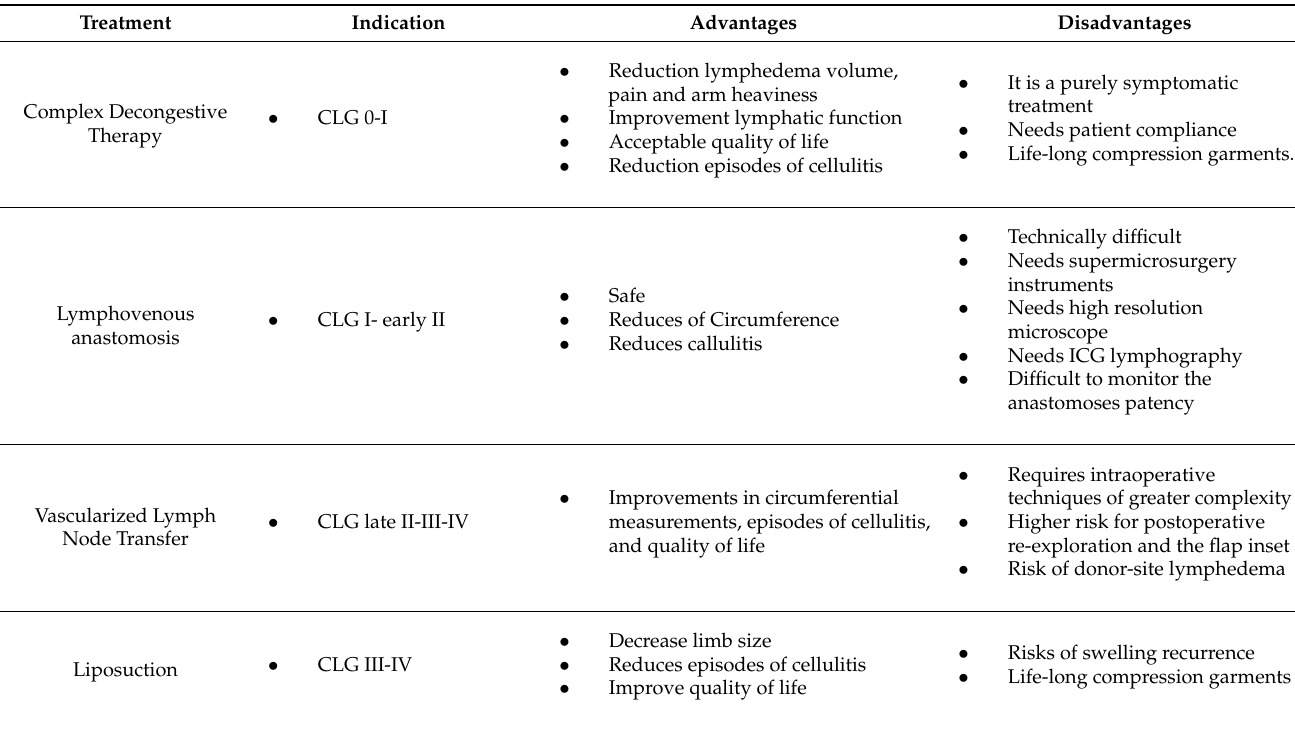
Table 3. Available Treatments for Patients with Breast Cancer-Related